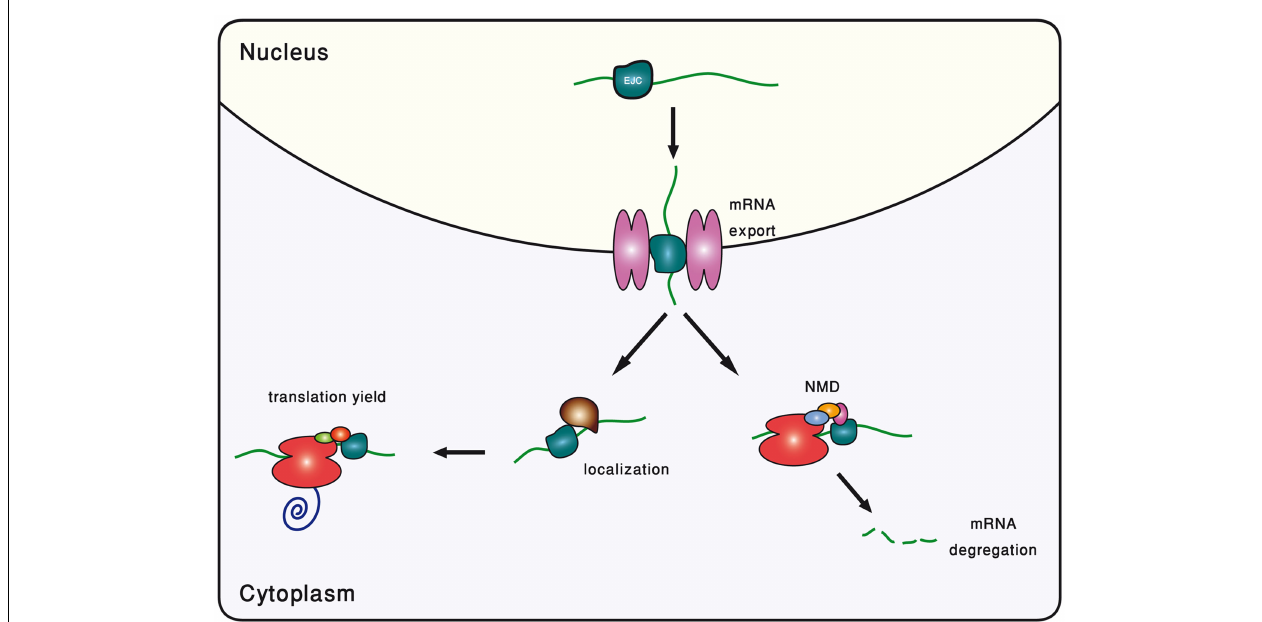
FIGURE 2 | Schematic description of the different roles played by the exon-junction complex (EJC).